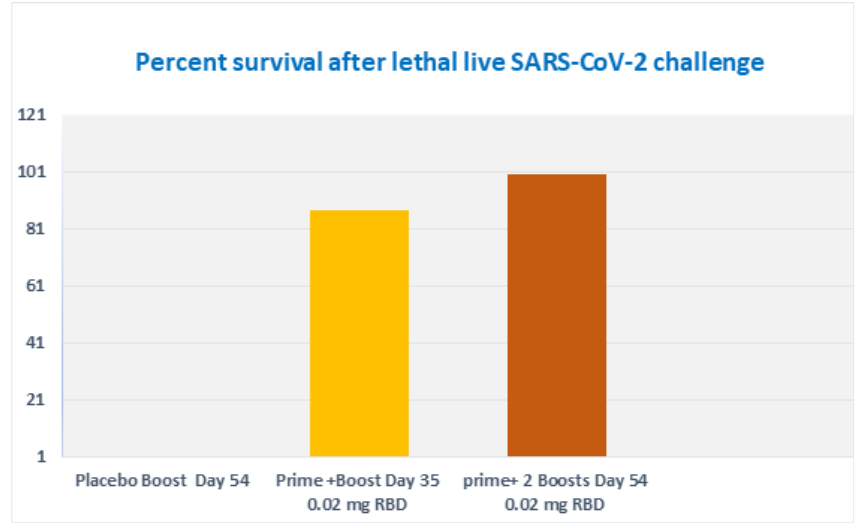
Figure 10. Precent survival of vaccinated K18-hACE2 transgenic C57BL/6J mice after Intra-Nasal challenge with lethal live SARS-CoV-2 virus. The prime-boost immunization regime protects 87.5% of mice that were challenged on day 41, 20 days after the boost immunization. The prime boost, boost immunization regime protected 100% of mice challenged on day 56, 14 days after the second boost immunization from the challenge with lethal live virus. All mice were monitored 21 days after the challenge.